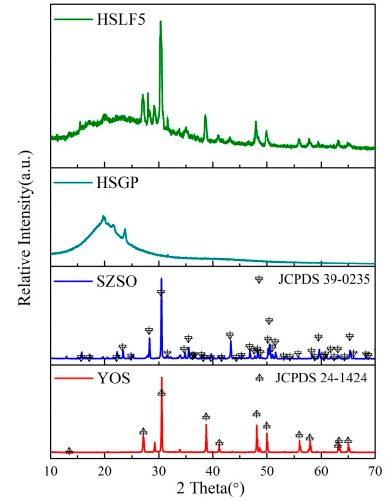
Figure 3. XRD patterns of HSLF5, HSGP, and rare-earth luminescent materials.